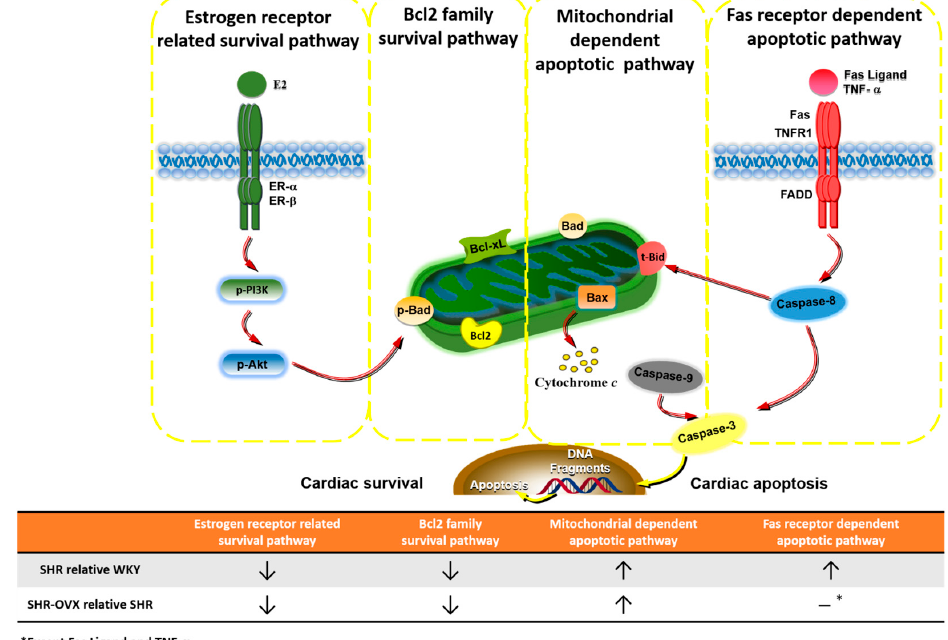
Figure 6. Proposed hypothesized diagram. Our hypothesis proposed that ovariectomy attenuated the estrogen receptor survival pathway (ER α , ER β and p-Akt/Akt, as well as Bcl-2, Bcl-xL and p-Bad) and activated the cardiac mitochondria-dependent apoptotic pathway (t-Bid, Bak, Bad, Bax, cytochrome c , activated caspase-9 and activated caspase-3), but did not activate the cardiac Fas receptor-dependent apoptotic pathway (Fas ligand, TNF- α , Fas, TNFR1, FADD and activated caspase-8) in the